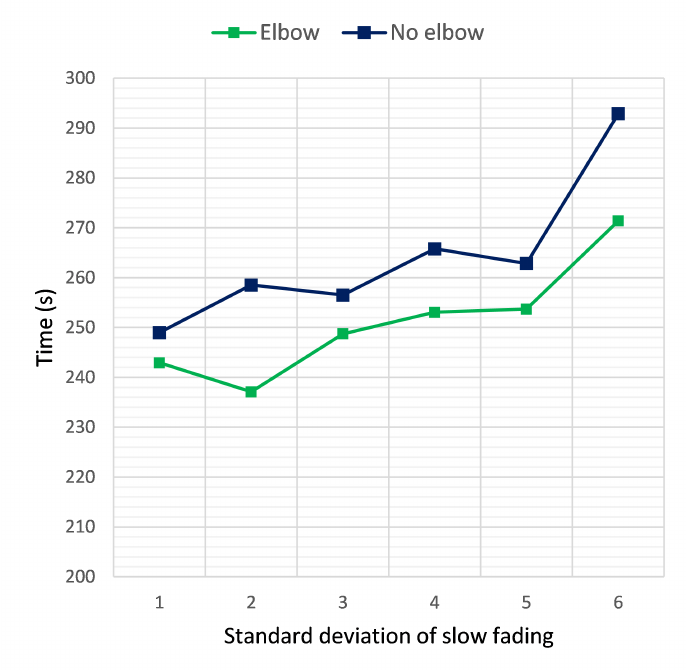
Figure 11. Time required for the first UAV to reach the target sensor when placed at a distance of 2 km, versus the standard deviation σ of the additive noise. Results at clustering termination thresholds of 20 dB, with and without using the elbow method to determine the number of